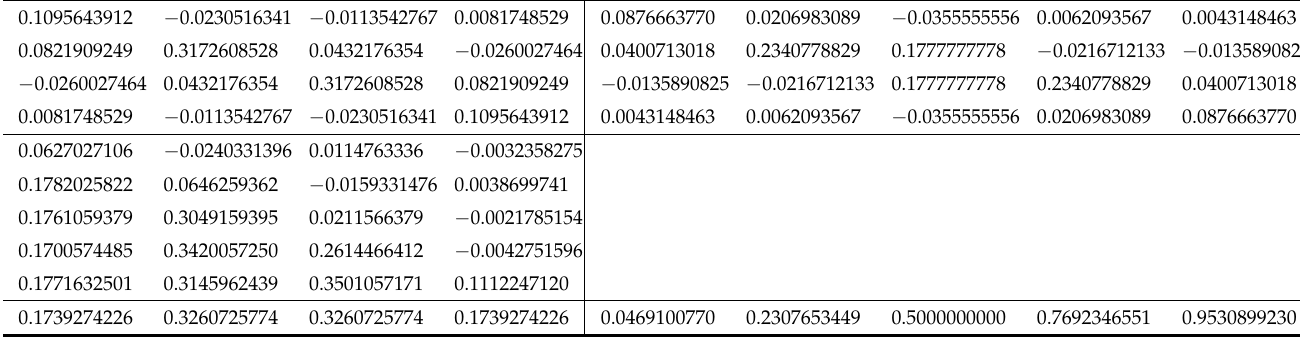
Table A15. G4|G5 method.